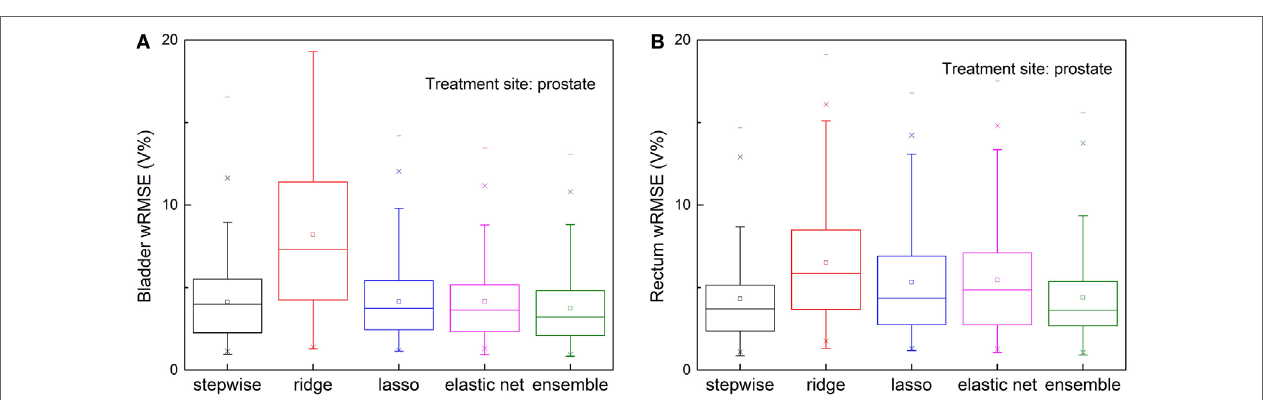
FigUre 5 | Prediction errors [Weighted root mean squared error (wRMSE)] of individual regression models and the proposed ensemble model for (a) bladder (B) rectum, in the presence of simulated anatomical outliers (see text). Forty prostate with seminal vesicle cases and 10 prostate cases with lymph node cases are used as the training set; 111 cases prostate with seminal vesicle cases are used as the validation set. For bladder prediction, the proposed ensemble method predicts significantly better than stepwise ( p = 0.013), ridge ( p < 0.001), lasso ( p = 0.002), and elastic net ( p < 0.001); for rectum prediction, the proposed ensemble method predicts significantly better than ridge ( p < 0.001), lasso ( p < 0.001), elastic net ( p < 0.001), and performs similarly well as stepwise ( p = 0.210).